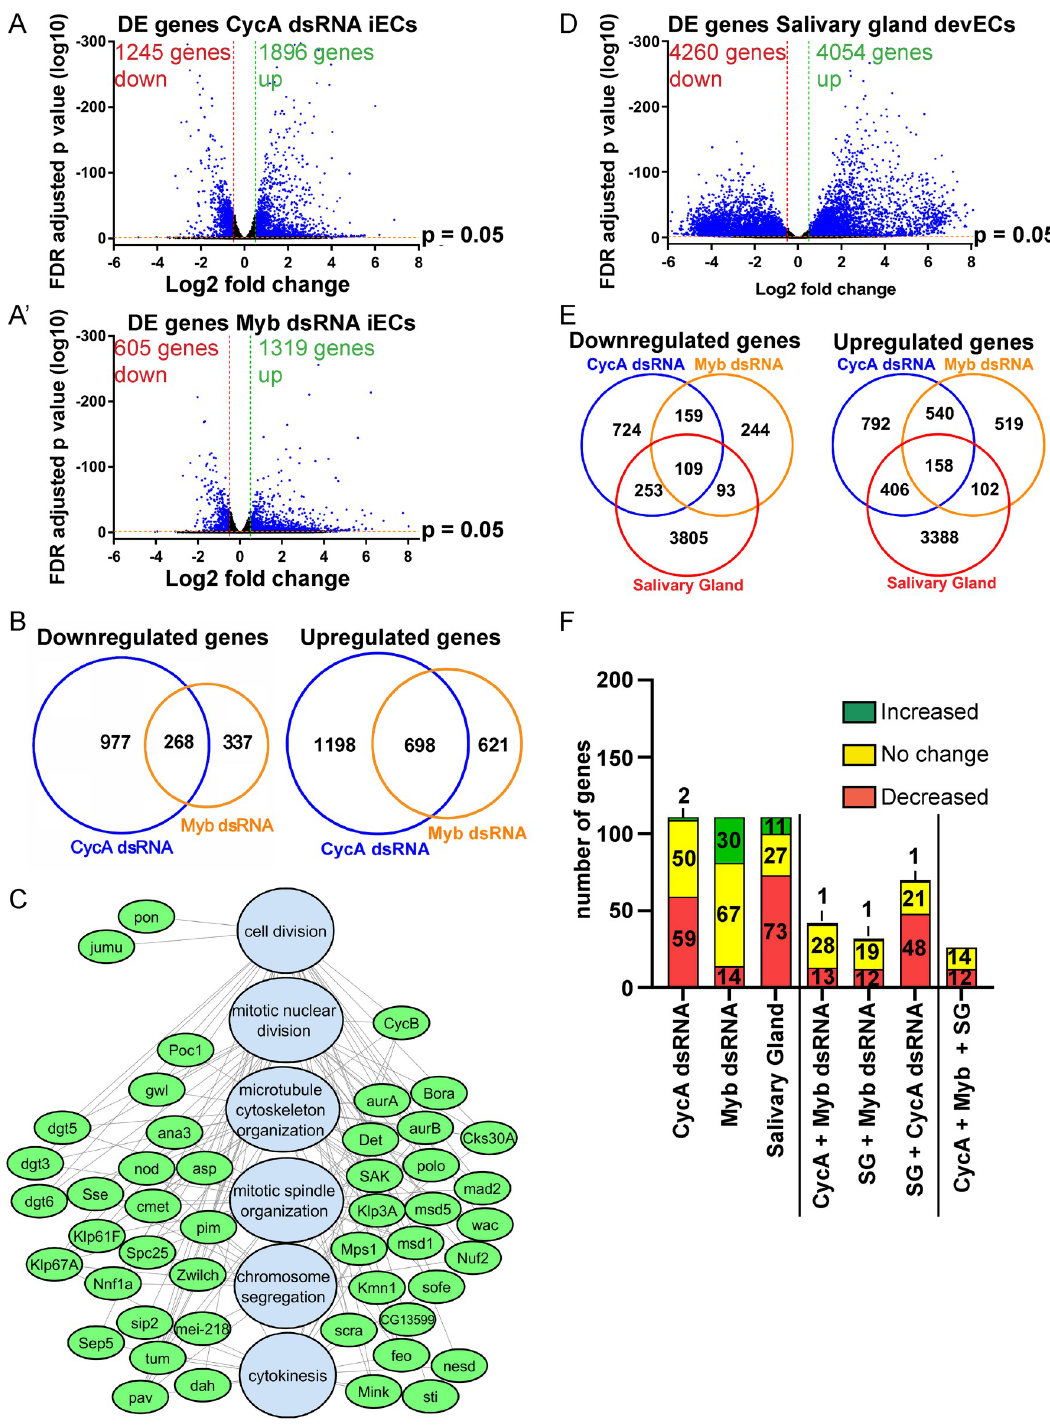
Fig 4. Both iECs and devECs have reduced expression of Myb target genes that function at multiple steps of mitosis and cytokinesis. (A, A’) Volcano plots of RNA-Seq results for differentially expressed (DE) genes in CycA dsRNA iECs (A) and Myb dsRNA iECs (A’) each relative to GFP dsRNA control cells (N = 3 biological replicates). Vertical red and green dotted lines indicate thresholds for log2 fold change ( � -0.5 and � +0.5) in iECs and horizontal red line the FDR adjusted p-value = 0.05. Blue dots represent genes that fulfill both of these criteria. See also S1 and S2 Tables. (B) Venn diagrams comparing the overlap of DE genes in CycA dsRNA and Myb dsRNA relative to control GFP dsRNA cells. See also S3 Table. (C) Gene Ontology (GO) analysis of genes